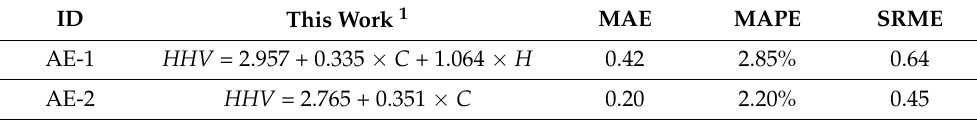
Table 10. Proposed equations, AE-1 and AE-2, based on ultimate analysis.